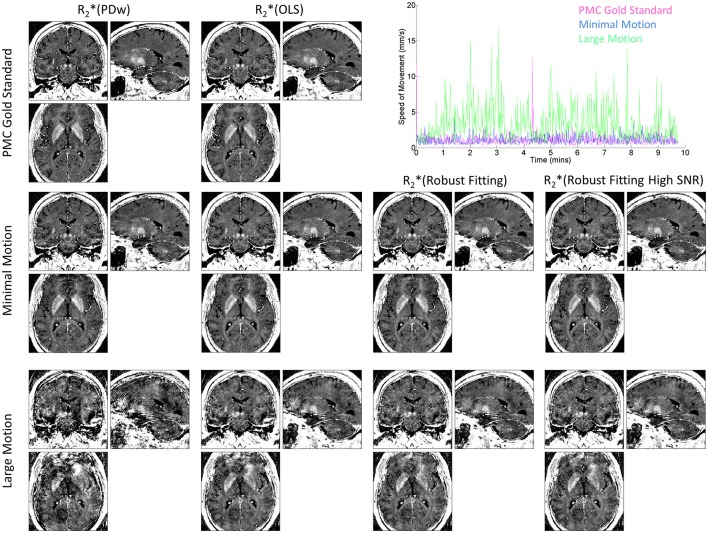
R2* maps at 800 μm isotropic resolution and corresponding motion trajectories in a single volunteer. High-speed optical motion tracking determined head motion and allowed for prospective motion correction (PMC). R2* maps were estimated with different methods. First column shows R2*(PDw), the last three columns show the different ESTATICS implementations. Rows show data with increasing levels of motion artifacts. First row shows data acquired with PMC and serves as the no motion artifact gold standard. Second row shows data acquired with minimal head motion without PMC. Third row shows data affected by motion during the PDw image acquisition without PMC. Top right panel shows speed of motion traces for the PDw image acquisitions for the three conditions.